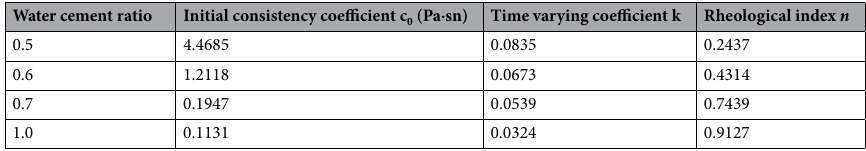
Table 2. Rheological properties of slurry with different water cement ratio.